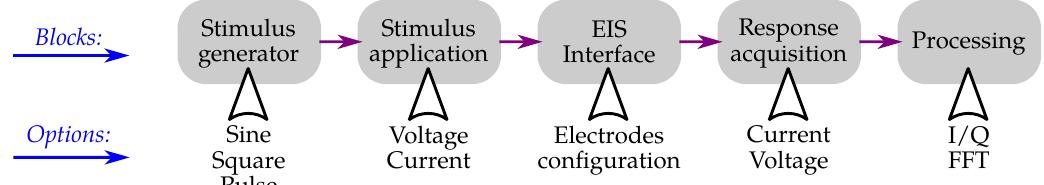
Figure 22. Fundamental elements of an electrochemical impedance spectroscopy (EIS)